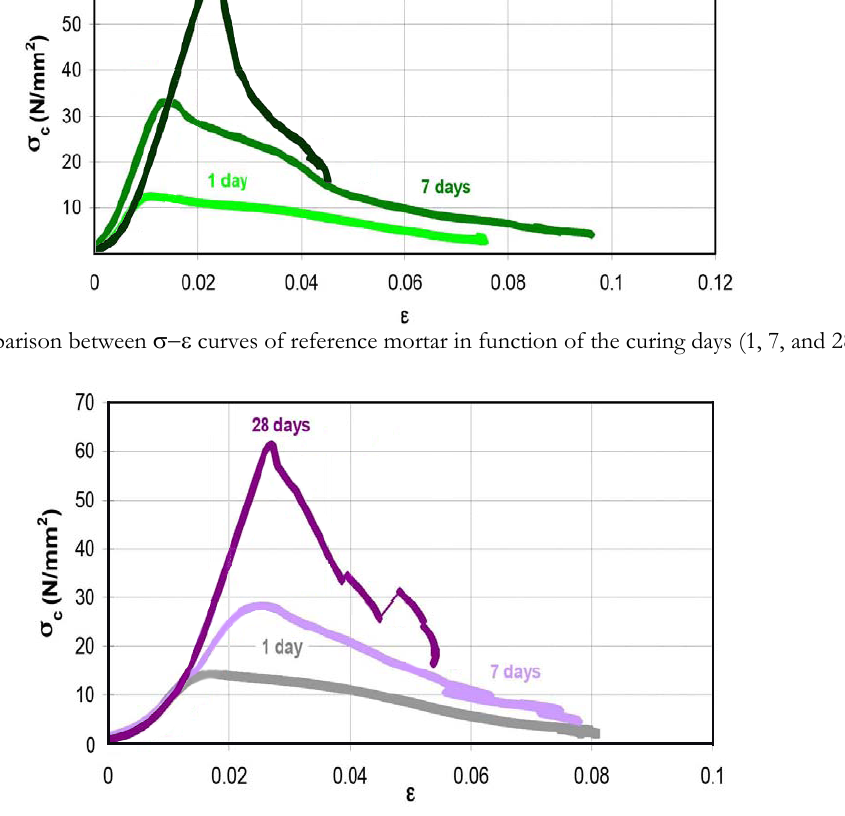
Figure 9: Comparison between  curves of 0.5 wt% CNT mortar in function of the curing days (1, 7, and 28 days).